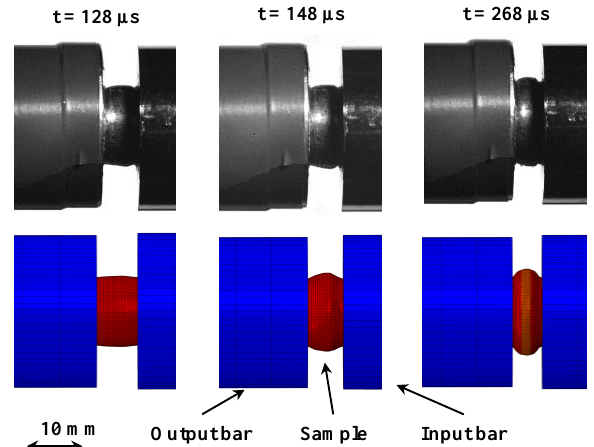
Fig 7. Comparison between experimental and numerical geometries observed during a SHPB test (striker velocity of 11 m/s, at room